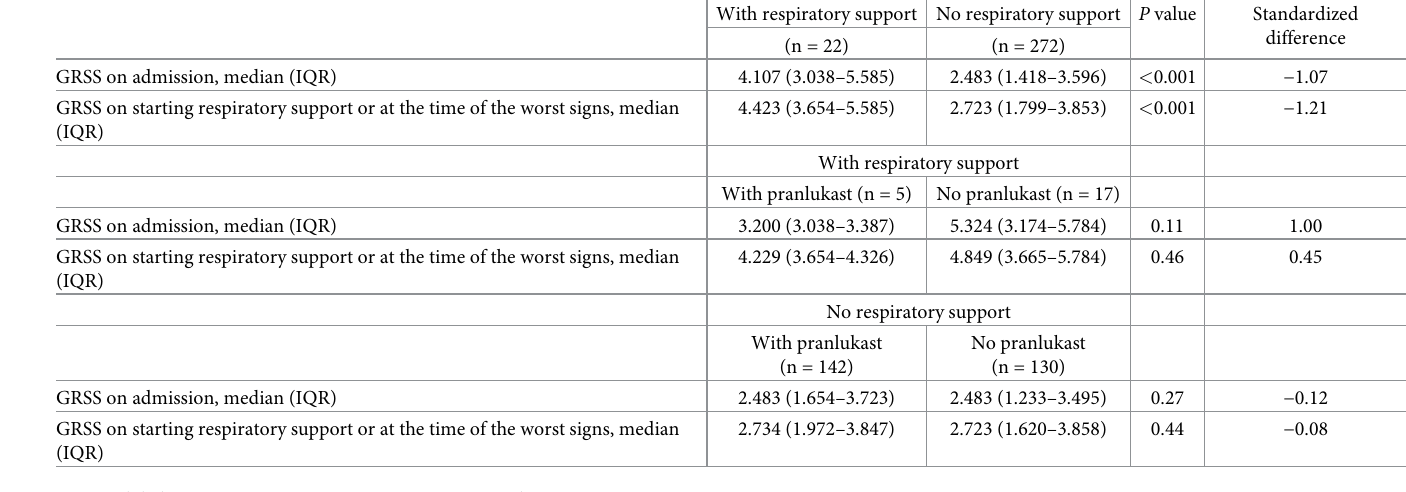
Table 2. Global Respiratory Severity Score on starting respiratory support or at the time of the worst signs after propensity score